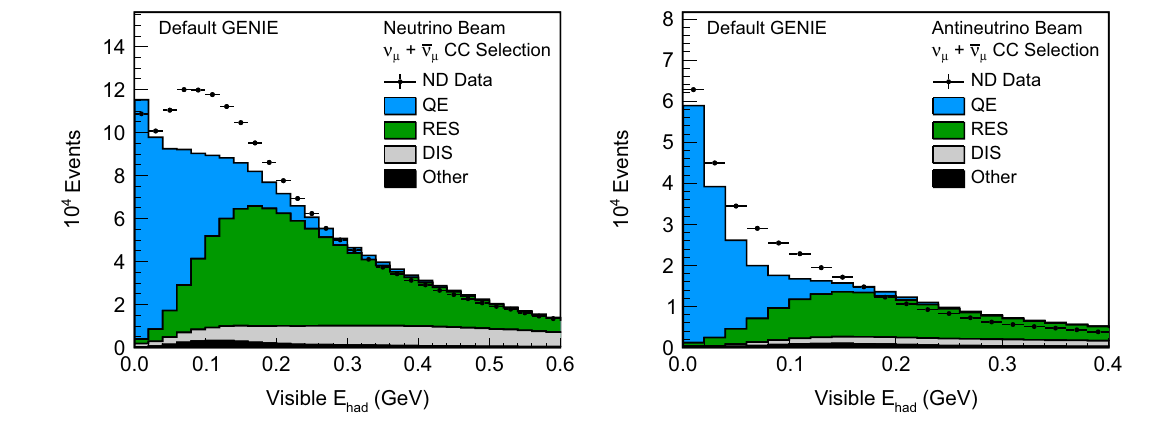
Fig. 1 Reconstructed visible hadronic energy distributions for neu- trino beam (left) and antineutrino beam (right), comparing NOvA near detector data and default GENIE 2.12.2 simulation. Data are indicated